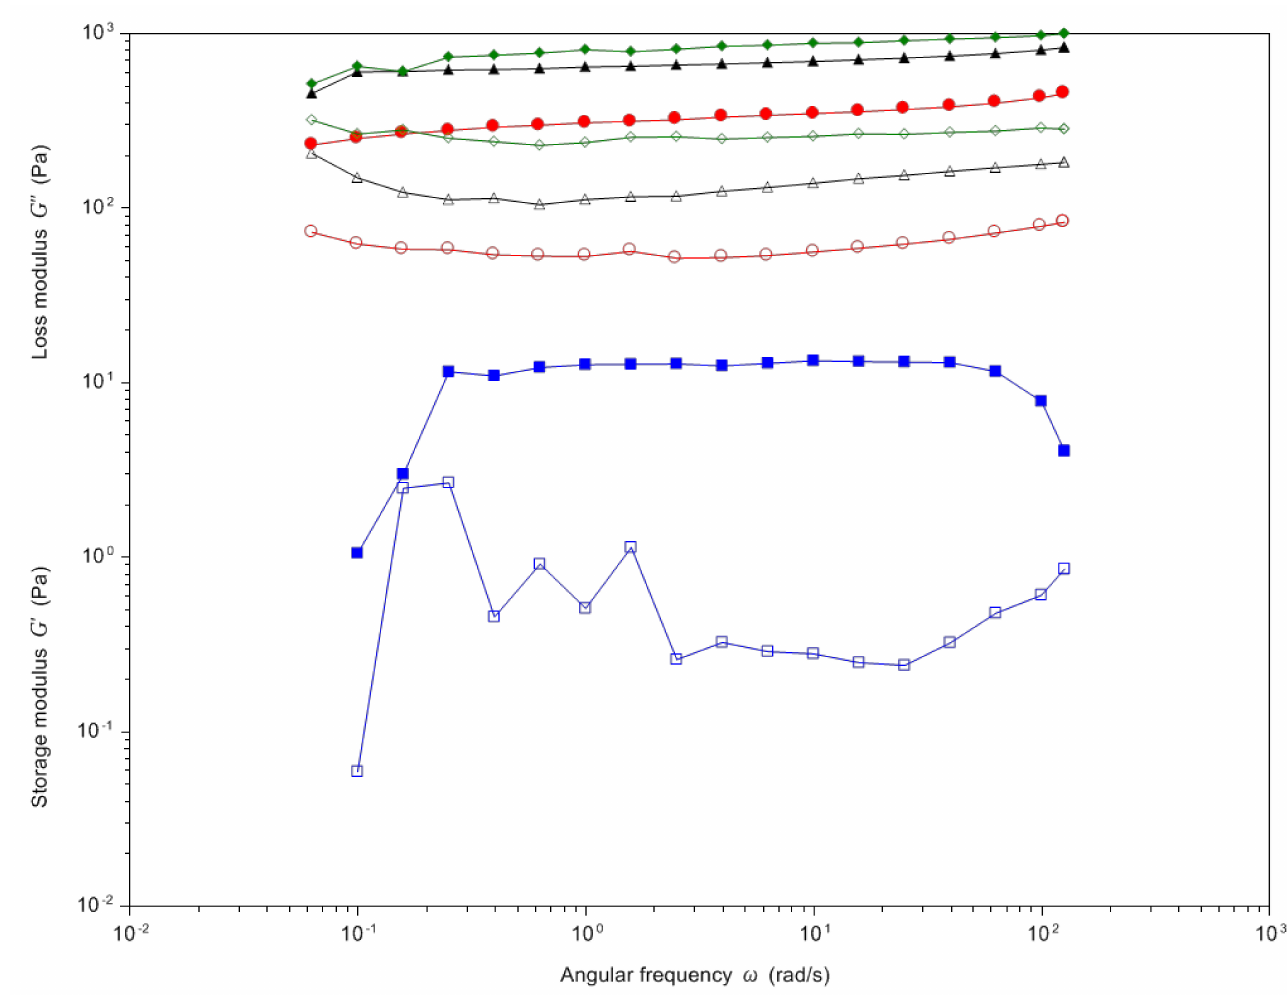
Figure 8. The storage (G (cid:48) : full symbols) and loss (G (cid:48)(cid:48) : empty symbols) moduli trend in the an- gular frequency range of 0.1–100 rad/s of the hydrogels obtained with HA(270)-FA-HEG-CL - 20 (green), HA(270)-FA-HEG-CL - 40 (black), HA(270)-FA-HEG-CL - 10 (red), and HA(8.7)-FA-HEG-CL - 20